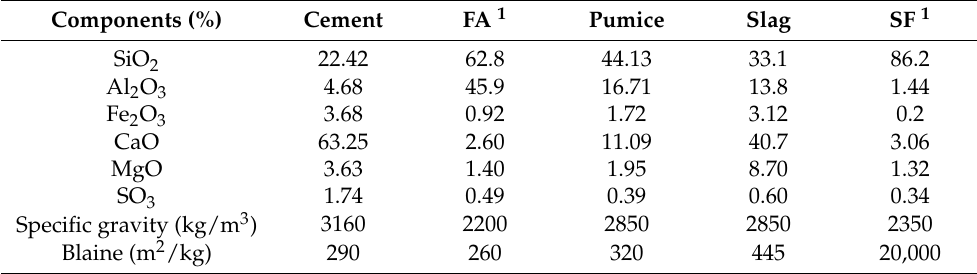
Table 1. The chemical components of Portland cement and other cementitious